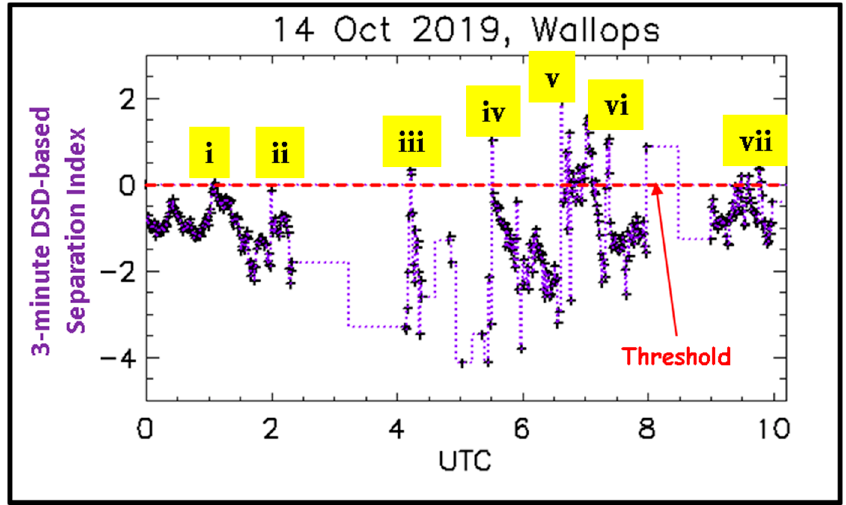
Figure 5. Variation of the ‘index’ parameter with time for the 14 October 2019 event. Cases (i) to (vii) are marked where the index reaches close to or above 0 threshold.